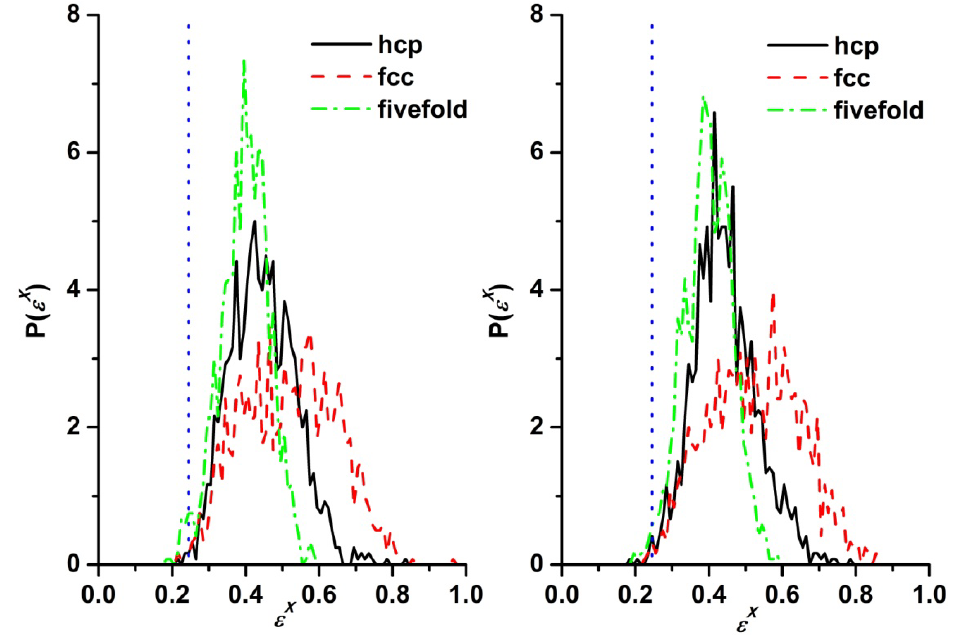
Figure 1. Characteristic crystallographic element (CCE)-based distribution with respect to hexagonal close packing (hcp), face center cubic (fcc) and fivefold symmetries as obtained from Monte Carlo (MC) simulations on the N = 12 system at φ = 0.56: ( left panel ) at the beginning and ( right panel ) at the end of the simulation. Also shown with vertical dotted lines are the threshold values of the CCE analysis ( ε thres = 0.245).